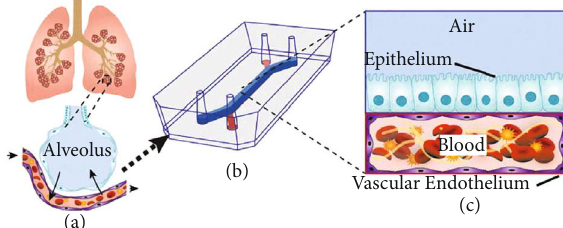
Figure 10: Microengineered model of human pulmonary thrombosis-on-chip. (a) A conceptual schematic of the human lung showing that the alveoli interact with the neighboring blood vessels during hemostasis or pulmonary dysfunction. (b) Engineering drawing of the microdevice. (c) Graphic illustration showing how the top compartment (1mm wide and 1mm tall) is cultured with human primary alveolar epithelial cells and the entire bottom chamber (1mm wide and 250mm tall) lined with human endothelial cells forming a lumen. Reproduced (or adapted) with permission [72], ©2017, American Society for Clinical Pharmacology and